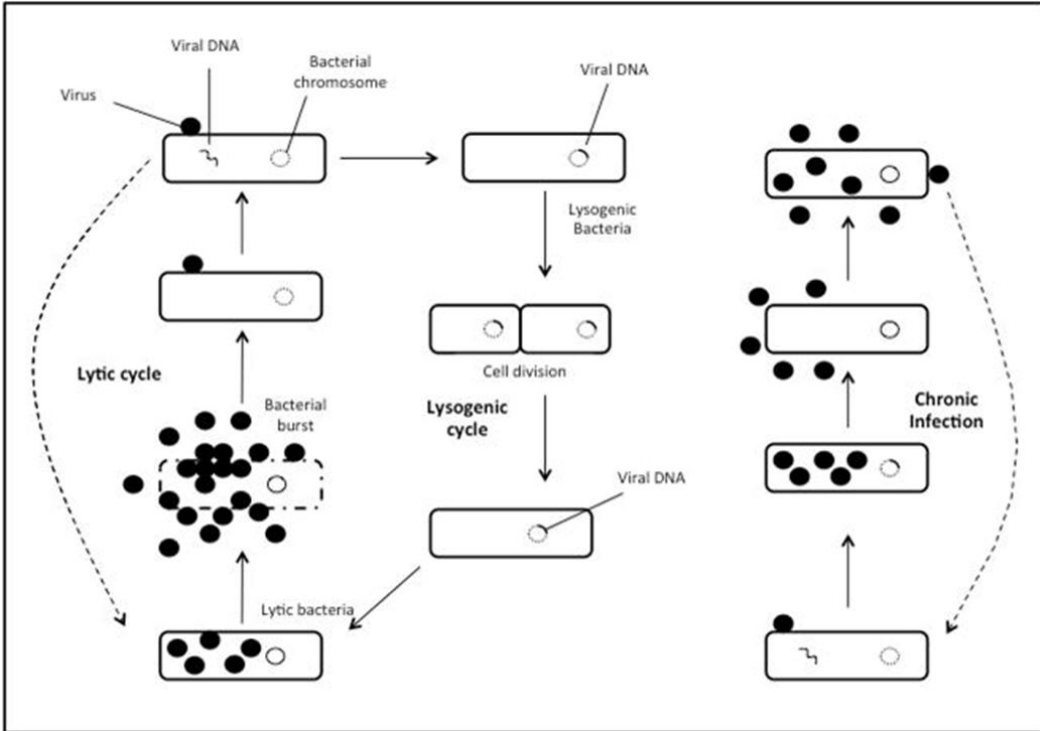
Figure 2. Simplified illustration of the three main virus replication strategies: lytic cycle, lysogenic cycle and chronic